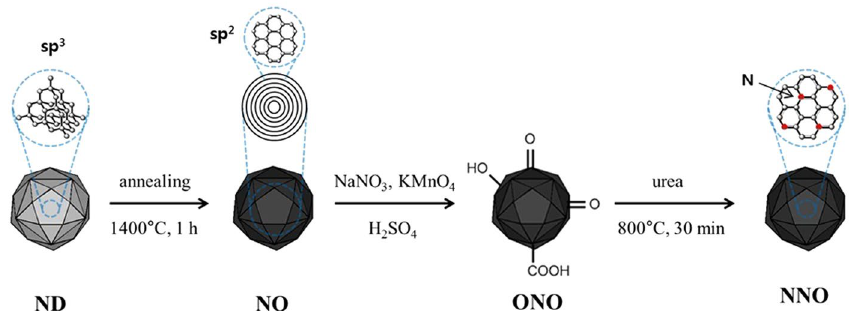
Figure 1. Schematic routes for the fabrication of NO, ONO, and NNO.